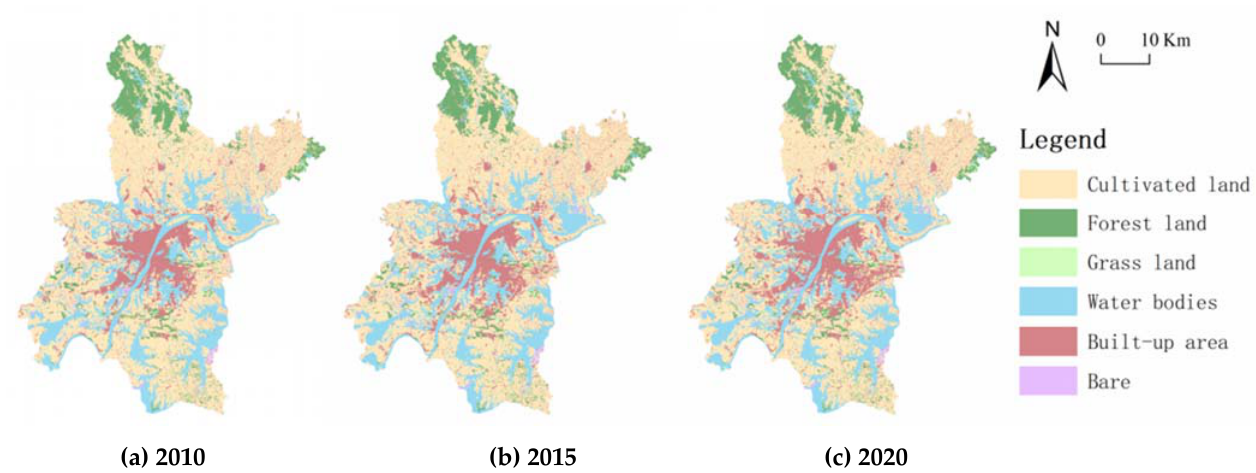
Figure 2. Land cover of Wuhan City in ( a ) 2010, ( b ) 2015, and ( c ) 2020.